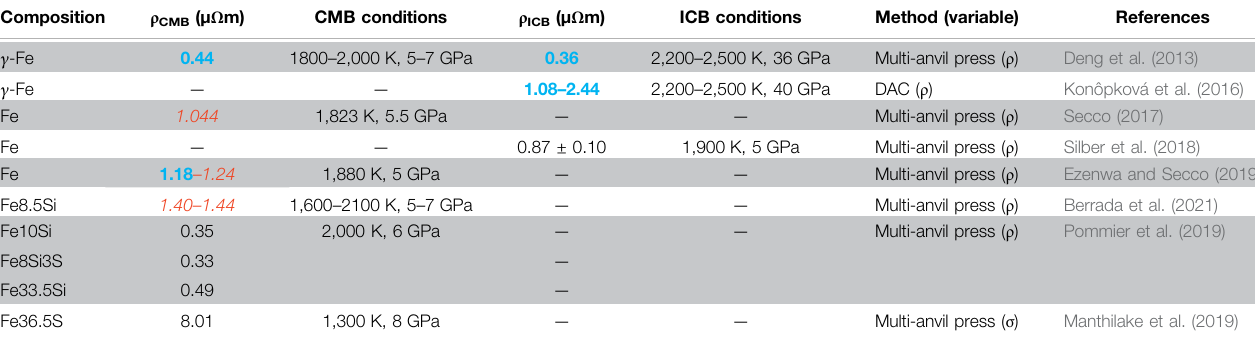
TABLE 6 | Electrical resistivity values of Fe and Fe-alloys according to different methods, at Mercury ’ s CMB and ICB conditions. Composition